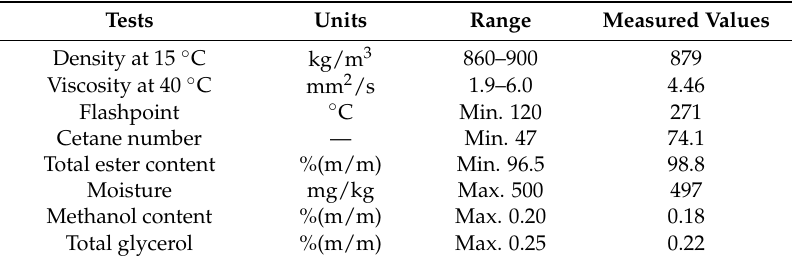
Table 1. Analysis report of palm